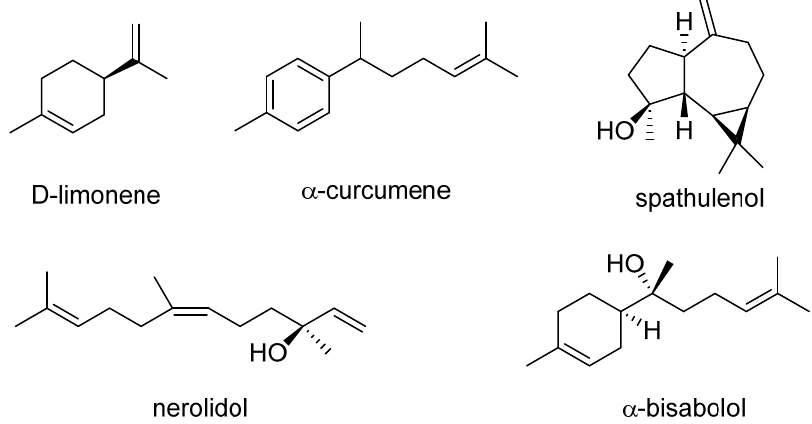
Figure 1. Major chemical constituents identified in the essential oil of A. ordosica .